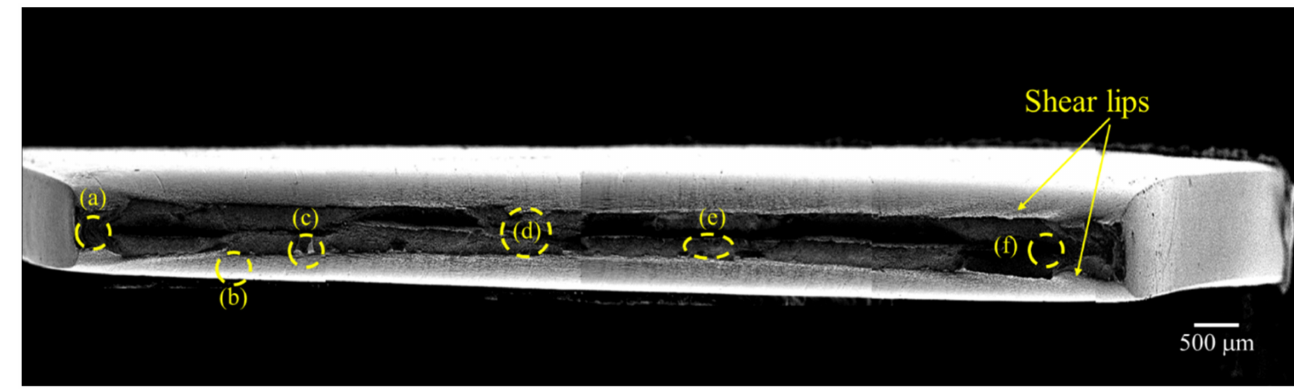
Figure 16. Sample tested at ε a = 0.006. The indications ( a – f ) correspond with the areas examined in the microscopic